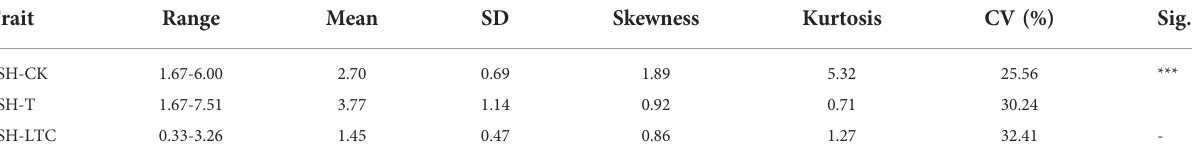
TABLE 1 Phenotypic variations of BSH in the maize association panel. Trait